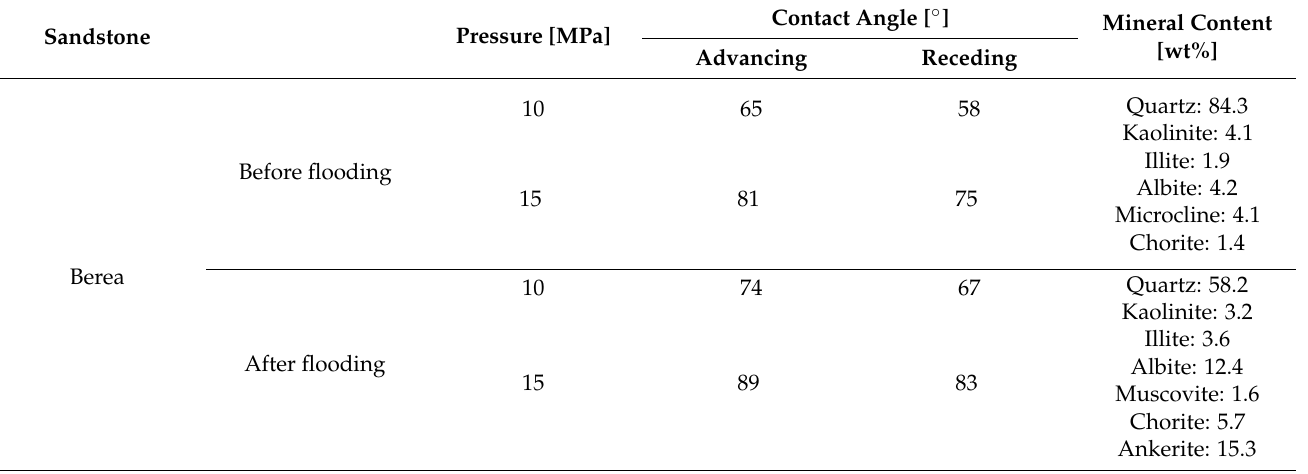
Table 5. Changes of sandstone under different pressures after sandstone reacted with CO 2 at 50 ◦ C for 7 days